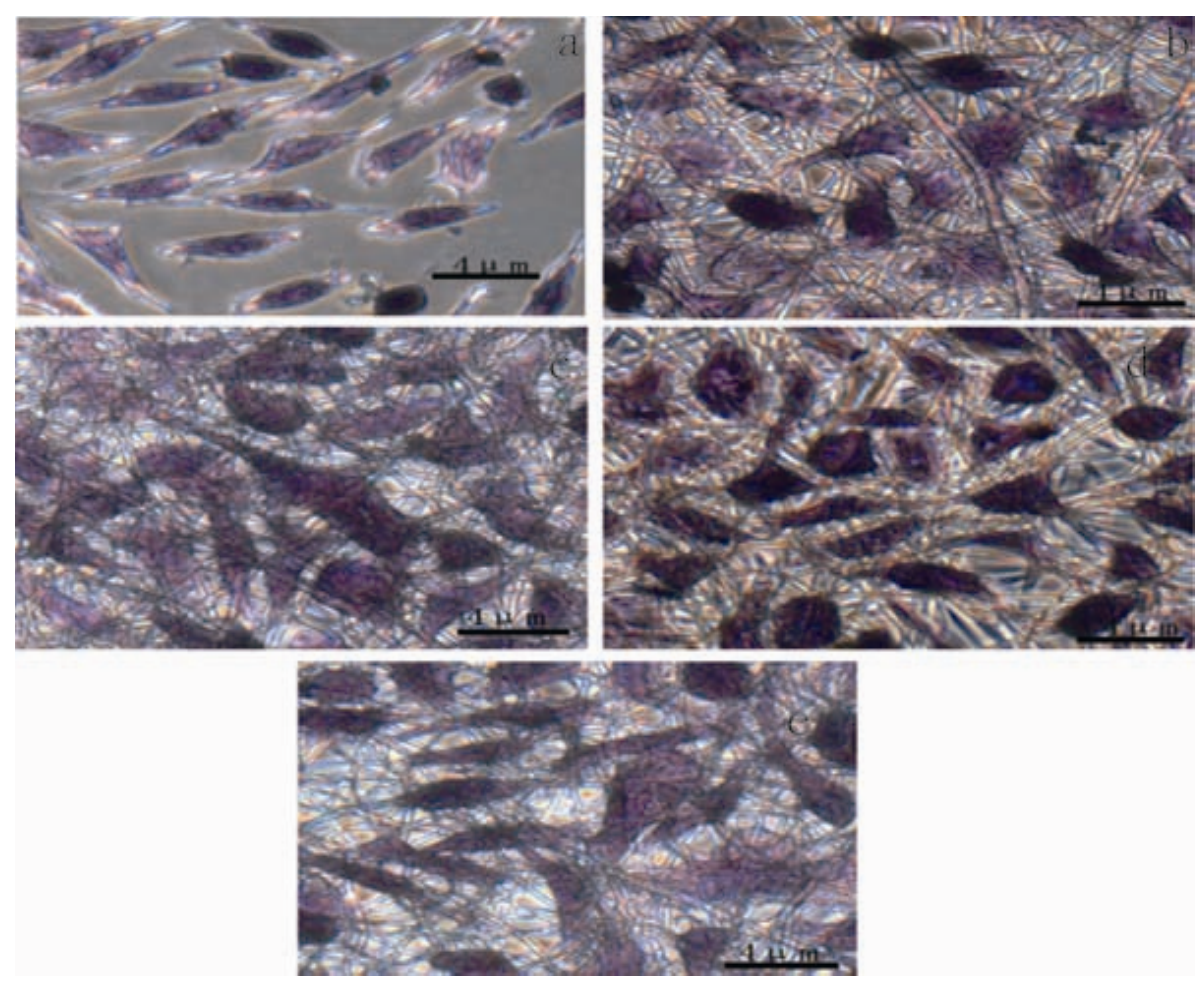
Figure 4. Comparison of fibroblasts proliferation on electrospun silk fibroin–chitosan nanofibers and controls: ( a ) glass cover slips; ( b ) CS/SF (80/20); ( c ) CS/SF